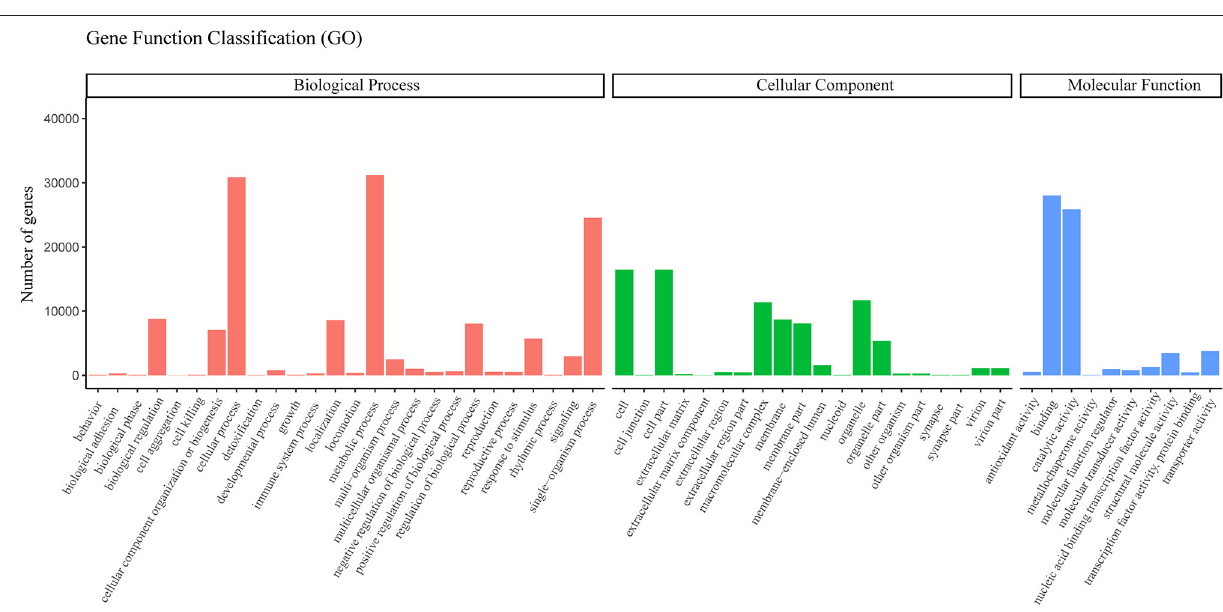
Frontiers in Genetics |